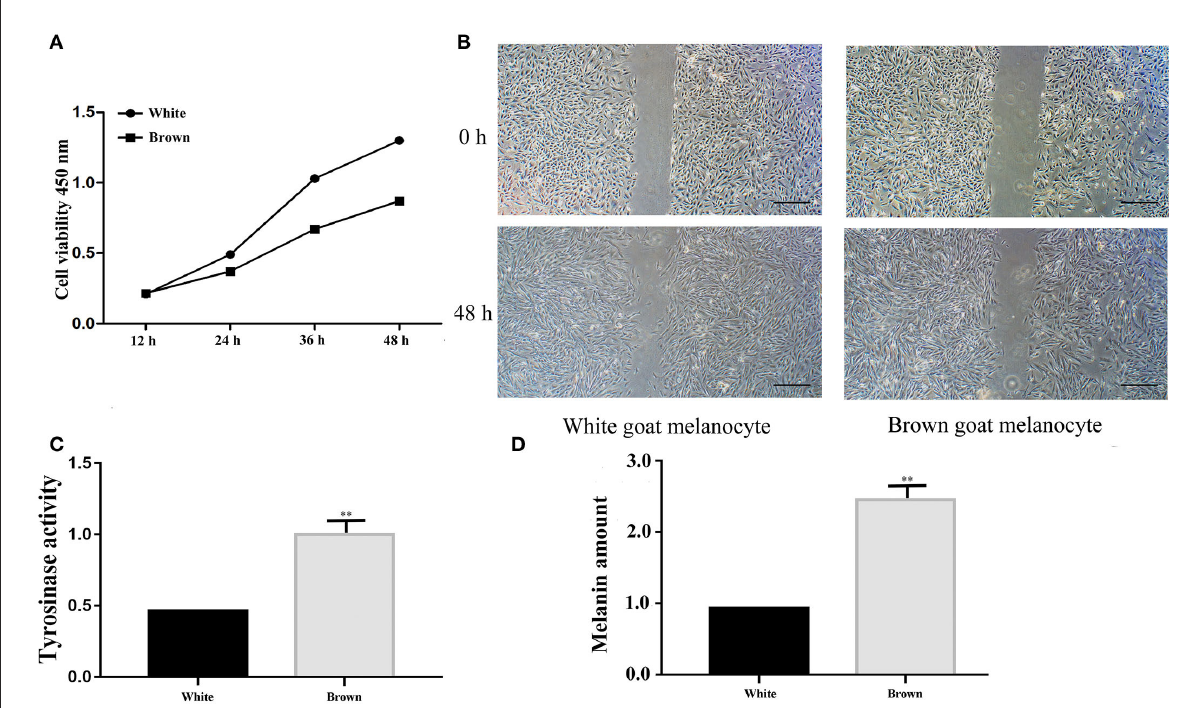
FIGURE2 Identification of melanocyte phenotypes isolated from Boer goat skins with white and brown hairs. (A) Proliferation rates of melanocytes as detected by a CCK8 assay. (B) Migration rates of melanocytes as detected by the wound-healing assay. (C) Tyrosinase activity of melanocytes as detected by L-dopa staining. (D) Melanin production of melanocytes as detected by an ASM assay. Data are shown as the means ± SD of relative fold-change ( n = 3 per group). ** P < 0.01. Bar =